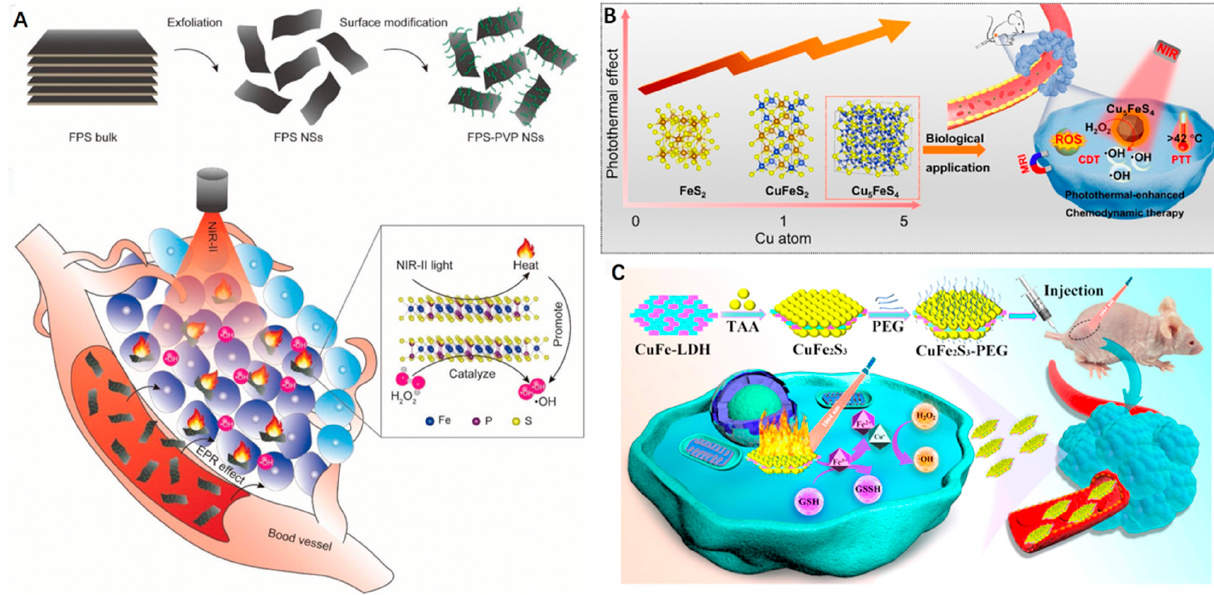
Figure 6. ( A ) Scheme of synthetic process of FPS-PVP nanosheets and their applications for synergistic CDT and PTT in the NIR-II biowindow. Inset is the ball-and-stick model of FPS. Reprinted with permission from Ref. [70]. Copyright 2020, Wiley-VCH Verlag GmbH & Co. KGaA, Weinheim. ( B ) The photoabsorption and photothermal effect of Cu x Fe y S z nano- materials can be tuned by changing the Cu/Fe ratios, and Cu 5 FeS 4 can be used as an efficient ‘‘one-for-all” type agent for MR imaging-guided photothermal-enhanced CDT. Reprinted with permission from Ref. [73]. Copyright 2021, Elsevier Inc. ( C ) Schematic illustration of the preparation of CuFe 2 S 3 -PEG nanosheets for efficient NIR-II PTT and CDT. Reprinted with permission from Ref. [74]. Copyright 2021, Elsevier Inc.